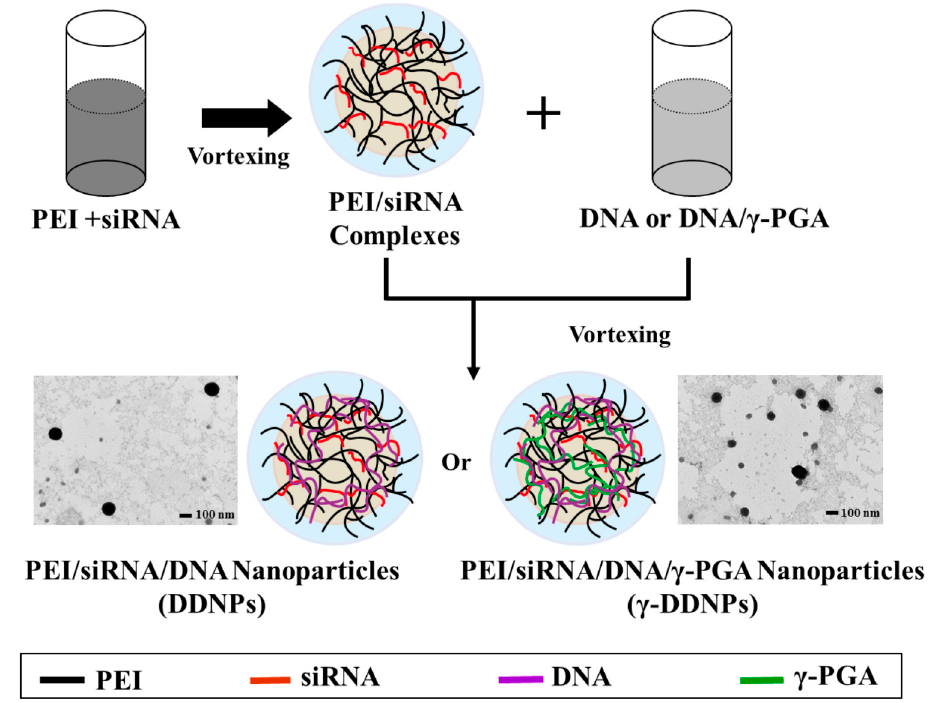
Figure 1. Schematic illustration of the preparation processes of DDNPs and γ -DDNPs. An aqueous siRNA solution was complexed with different amount of PEI to be followed by mixing with plasmid DNA or plasmid/ γ -PGA by vortexing to form DDNPs or γ -DDNPs, respectively. The TEM images of DDNPs or γ -DDNPs were shown.